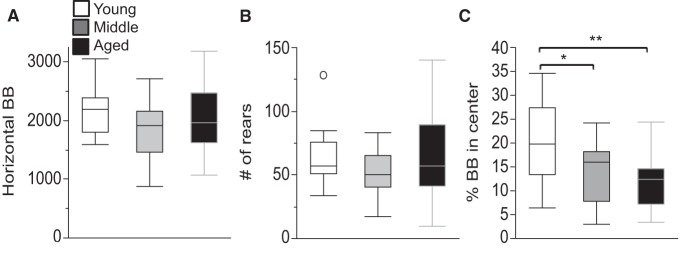
Unchanged locomotor and rearing activity, but reduced percentage of activity in the center of the arena in aged mice. A, B, The total number of horizontal beam breaks (A) and rearings (B) are shown. No significant differences were detected between any of the age groups in either measure. C, The percentage of beam breaks that were recorded in the center of the locomotor arena is shown. Values are expressed as box plots, as defined in the Data analysis section of Materials and Methods. BB, Beam breaks. *p < 0.05, **p < 0.005.